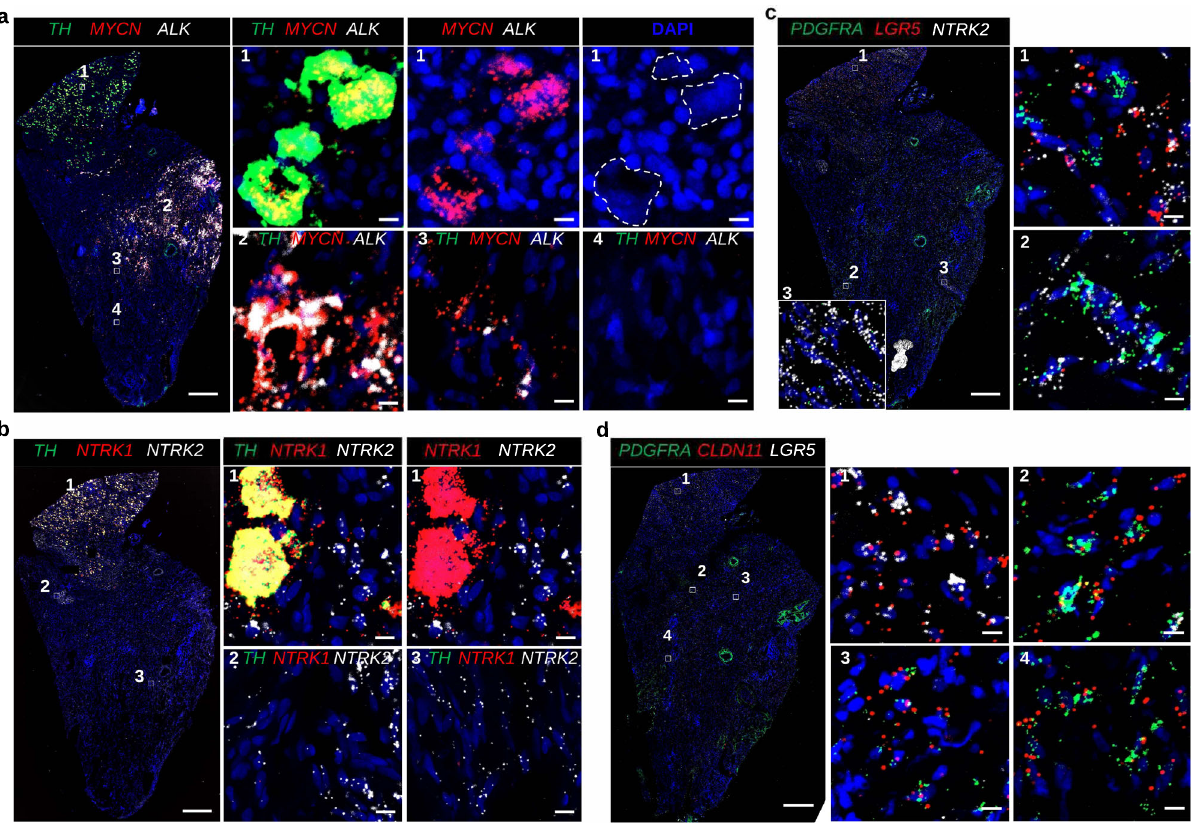
Fig. 4 RNA in situ hybridization validating intratumoral heterogeneity in high-risk neuroblastoma stage 4. Overview of tile-scanned images (20x) high- risk neuroblastoma (K10, MYCN ampli fi ed) using RNAscope in situ hybridization. Scalebar of overview: 500 μ m; zoom of boxed image: 10 μ m. a Tumor labeled with RNAscope ISH for TH (green), MYCN (red), and ALK (white) mRNA, and counter stained with DAPI (blue). Dashed circles indicate cells with large nuclei in a region (box #1), that are TH and MYCN positive, but negative for ALK . Box #2 indicates part of the tumor with majority of cells double positive for MYCN and ALK but negative for TH . Box #4 indicates cells negative for all probes: TH , MYCN , and ALK . b Adjacent section from ( a ) labeled for TH (green), NTRK1 (red), and NTRK2 (white). Box #1 indicate cells with large nuclei in a region that are TH + and NTRK1 + , and negative for NTRK2 . Surrounding cells with small nuclei are positive for NTRK2 only. Box #2,3 visualizes tumor region with majority of cells positive for NTRK2 that are negative for TH and NTRK1 . c Adjacent section stained for PDGFRA (green), LGR5 (red), and NTRK2 (white) mRNA is highlighting cells double positive for LGR5 and NTRK2 (box #1) or double positive for PDGRFA , NTRK2 (box #2). Box #3 indicates a region of the tumor that is positive for NTRK2 only. d Adjacent section stained for mesenchymal markers PDGFRA (green), CLDN11 (red), and LGR5 (white). Similar to c : some tumor regions (box #1) highlight cells double positive for CLDN11 (red) and LGR5 (white) that are negative for PDGFRA (box #1), as were other regions show cells that are double positive for PDGFRA (green) and CLDN11 (red) (box #2, 3, and 4). For all RNAscope experiments, the signal distribution patterns and cell morphological features were shown by the different combination of probes and independently reproduced three times on different samples in ( a ) and ( b ), and independently reproduced four times on different samples in ( c ) and (